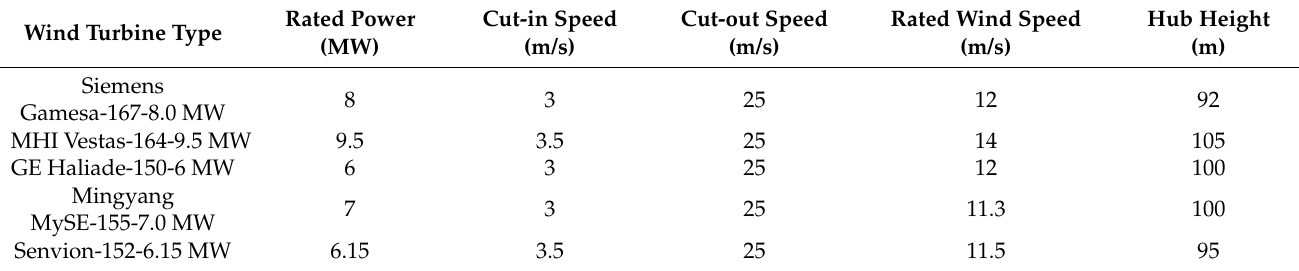
Table 1. Characteristics of the five wind turbines evaluated.